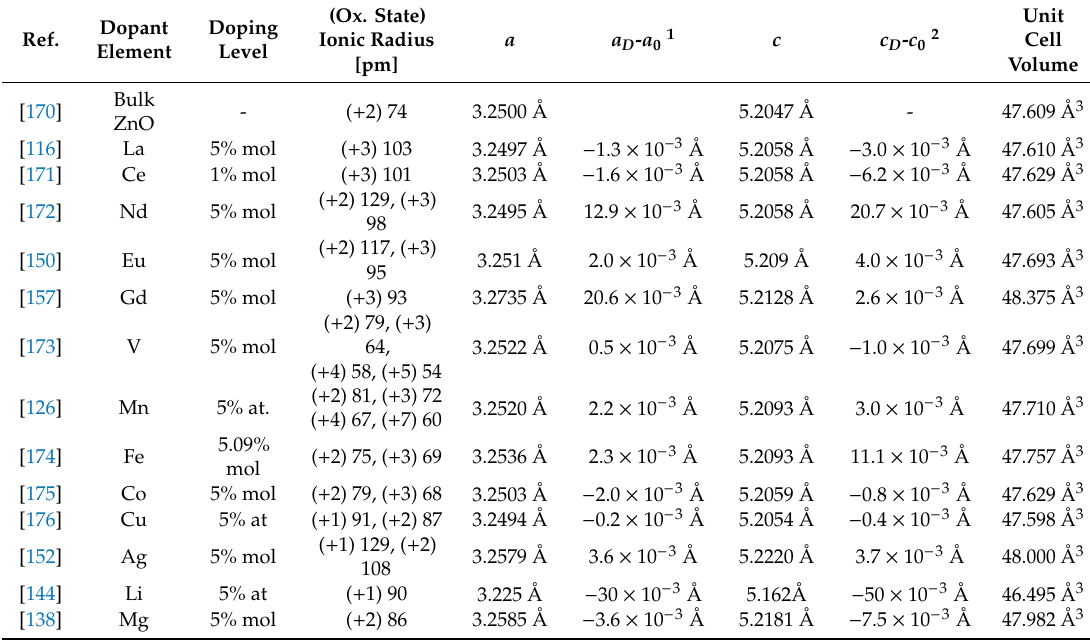
Table 1. Doped ZnO structural